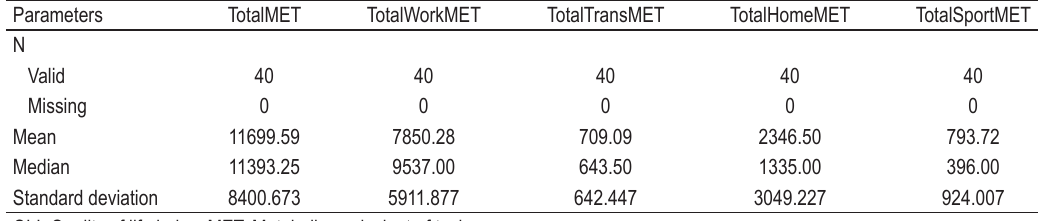
TABLE 12. Total daily activity and the QLI